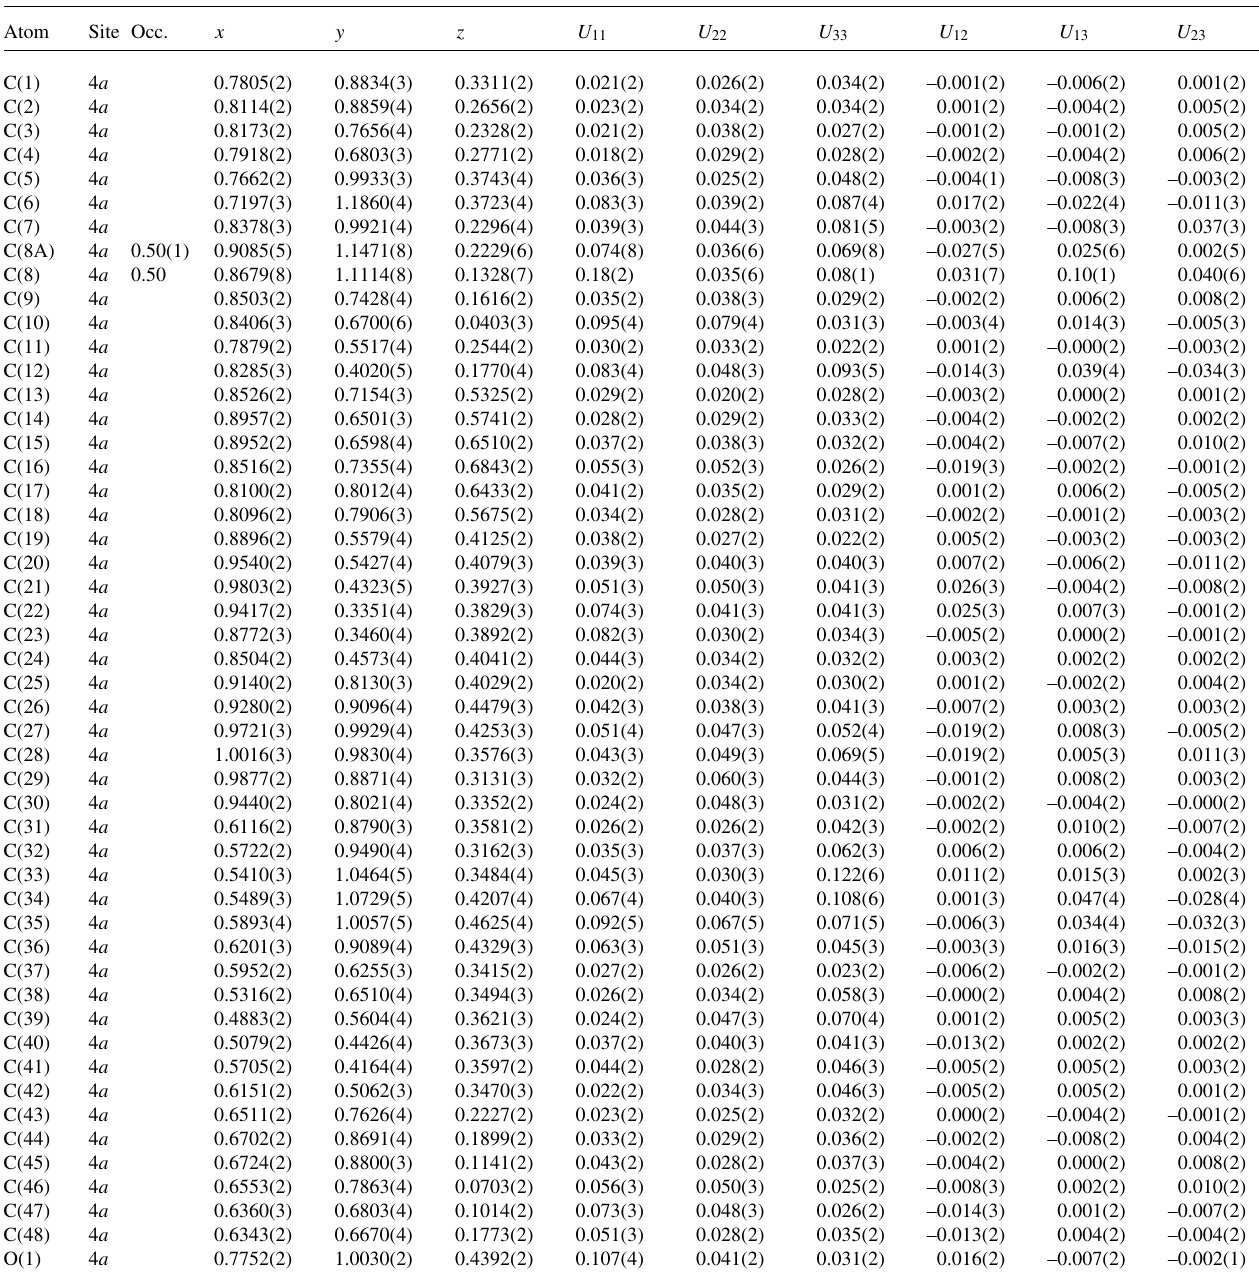
Table 3. Atomic coordinates and displacement parameters (in Å 2 )